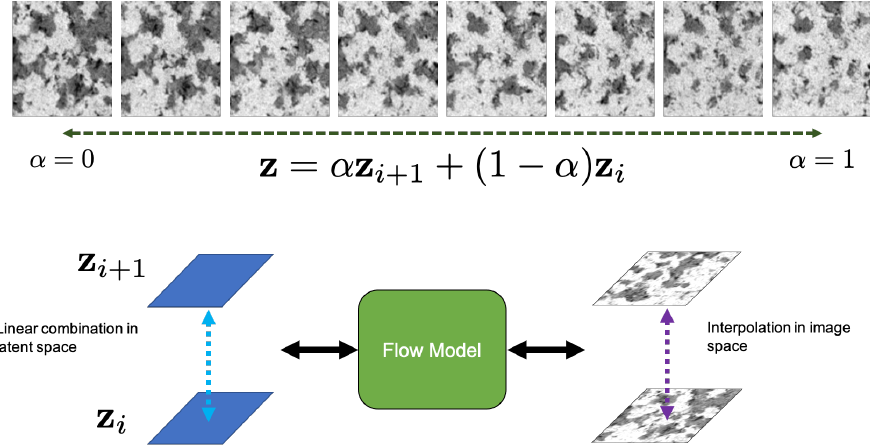
Figure 2. Depiction of the linear interpolation property of the RockFlow porous media generation algorithm (top). For generative flow models, linear interpolation in the latent space is equivalent to semantic interpolation in image space (bottom).